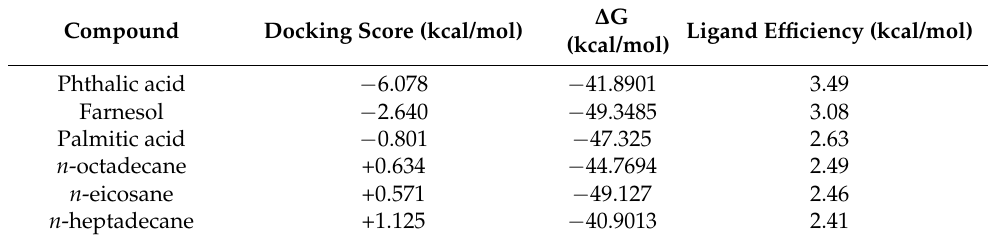
Table 1. Docking score and ligand efficiency of glutathione and 16 phytochemicals previously reported in a non-polar fraction of the methanol extract of L. indica leaves [7] towards PGD 2 synthase. ∆ G Compound Docking Score (kcal/mol) Phthalic